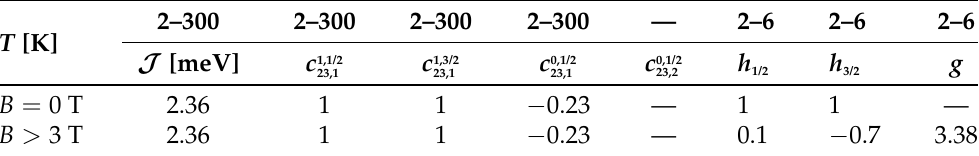
Table 3. The values of all parameters entering (2) for the neutral compound [(Pc)Er{Pc{N(C 4 H 9 ) 2 } 8 }] · . The first row shows the temperature under which a parameter is fitted. The evaluation of J , the spectroscopic ‘ c ’ and field ‘ h ’ parameters is made with respect to the magnetization measurements depicted on Figure 10. The experimental data are provided in Reference [24].